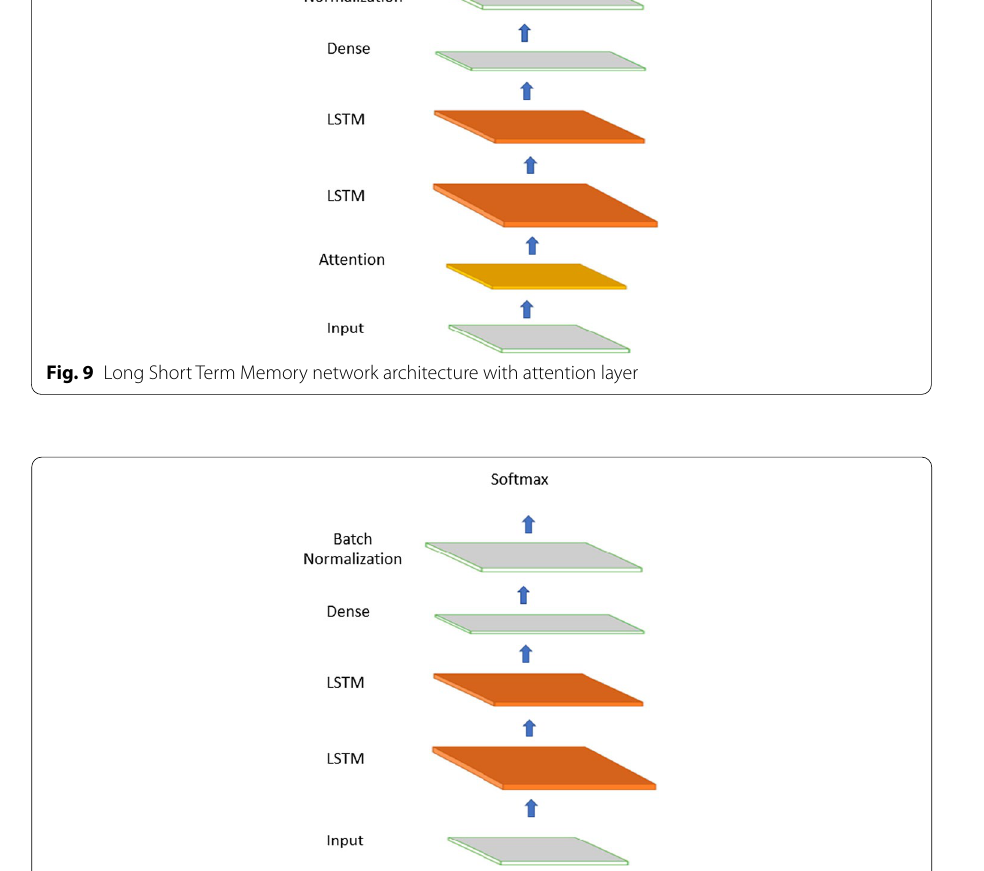
Fig. 10 Long Short Term Memory network architecture without attention